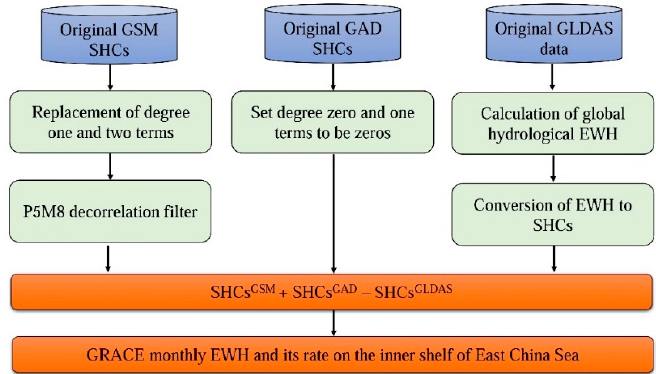
Figure 2. A flowchart of GRACE data processing for determining sediment deposition. SHC, spherical harmonic coefficient; GLDAS, Global Land Data Assimilation System; EWH, equivalent water height.